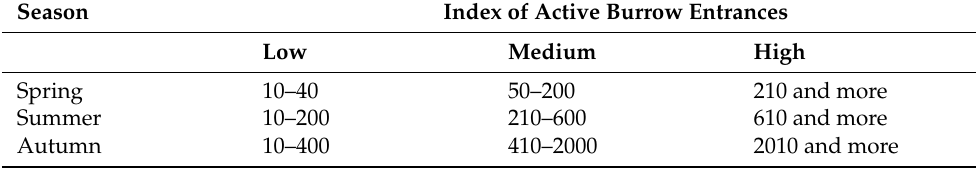
Table 5. Classification of vole densities according to a new monitoring method based on counts of active burrow entrances